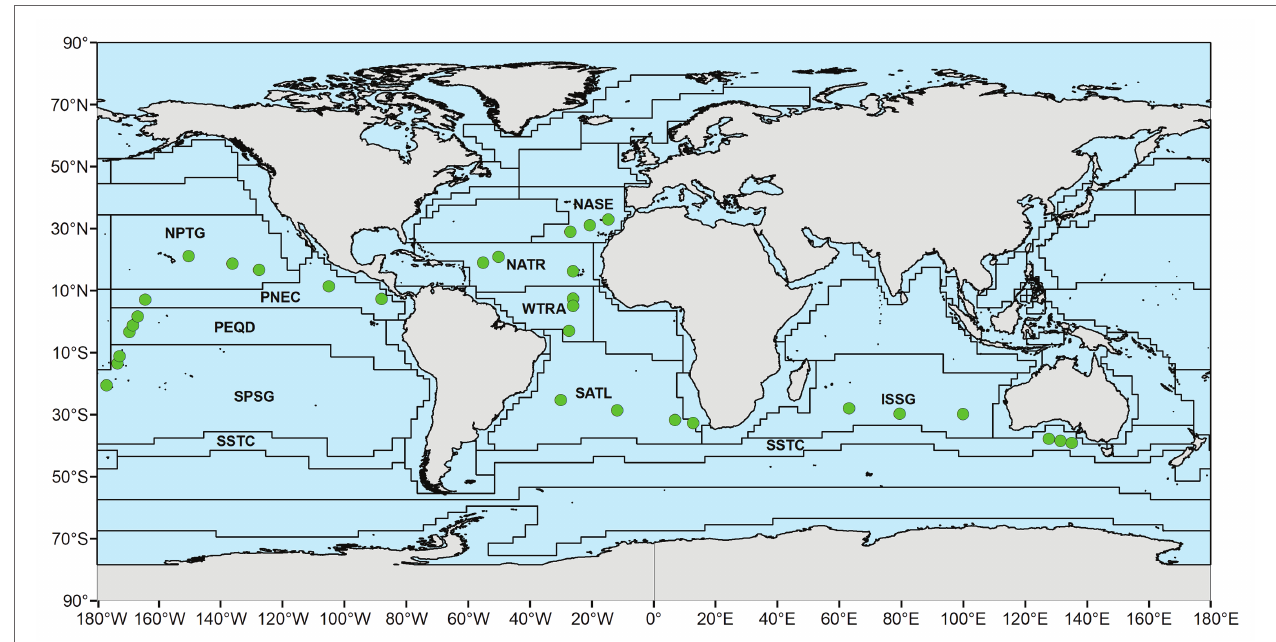
FIGURE 1 | Location of the stations sampled in this study, indicated by green circles. Stations were grouped in distinct biogeochemical provinces according to Longhurst (2007) with acronyms depicted. Shapefile adapted from Flanders Marine Institute